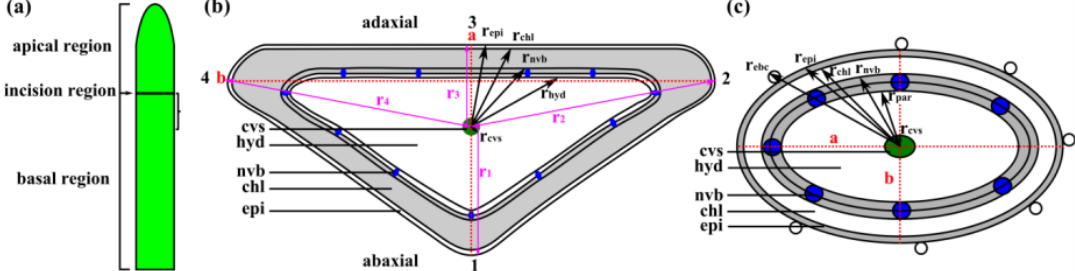
Figure 11. Schematic representation of a leaf ( a ), which was divided by the incision region into the apical region equaling one-third and the basal region equaling two-thirds of the total leaf length. Schematic drawings of transverse sections of leaves of ( b ) D. ecklonis and ( c ) D. cooperi (based on investigations in [15]). The epidermis (epi), chlorenchyma (chl, grey), net of peripheral vascular bundles (nvb, blue), hydrenchyma (hyd) and central vascular strand (cvs, green) have been simplified to five consecutive tissue layers. The thickness of each tissue layer was calculated for D. cooperi by measurements along the diameters a and b (red dotted lines) and for D. ecklonis by measurements along the pink lines r 1 –r 4 (see Appendix C).The tissue arrangement within a transverse section of a leaf of D. ecklonis or D. cooperi can be simplified to five consecutive layers with the central vascular strand (cvs) being the inner most layer followed by the hydrenchyma (hyd), the peripheral net of vascular bundles (nvb), the chlorenchyma and then the epidermis (epi) as the outermost layer (Figure 11b,c).